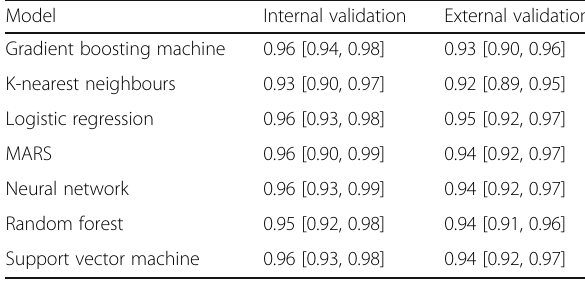
Table 2 ROC AUC [95% CI] performance comparison of the seven models applied to the internal and external validation datasets. Internal validation was estimated with 5-fold-nested cross-validation while external validation was performed on the YDX